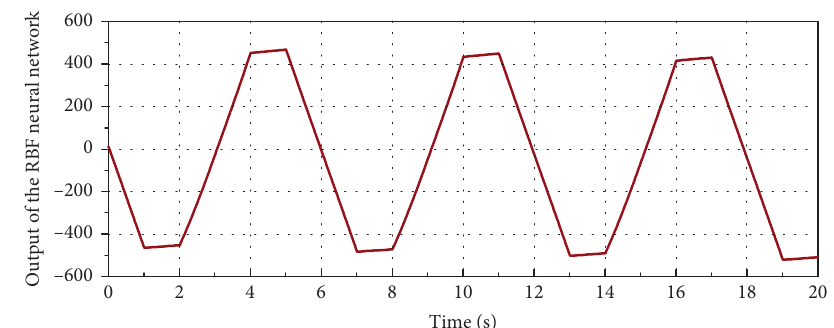
Figure 16: Tracking error in test 2.